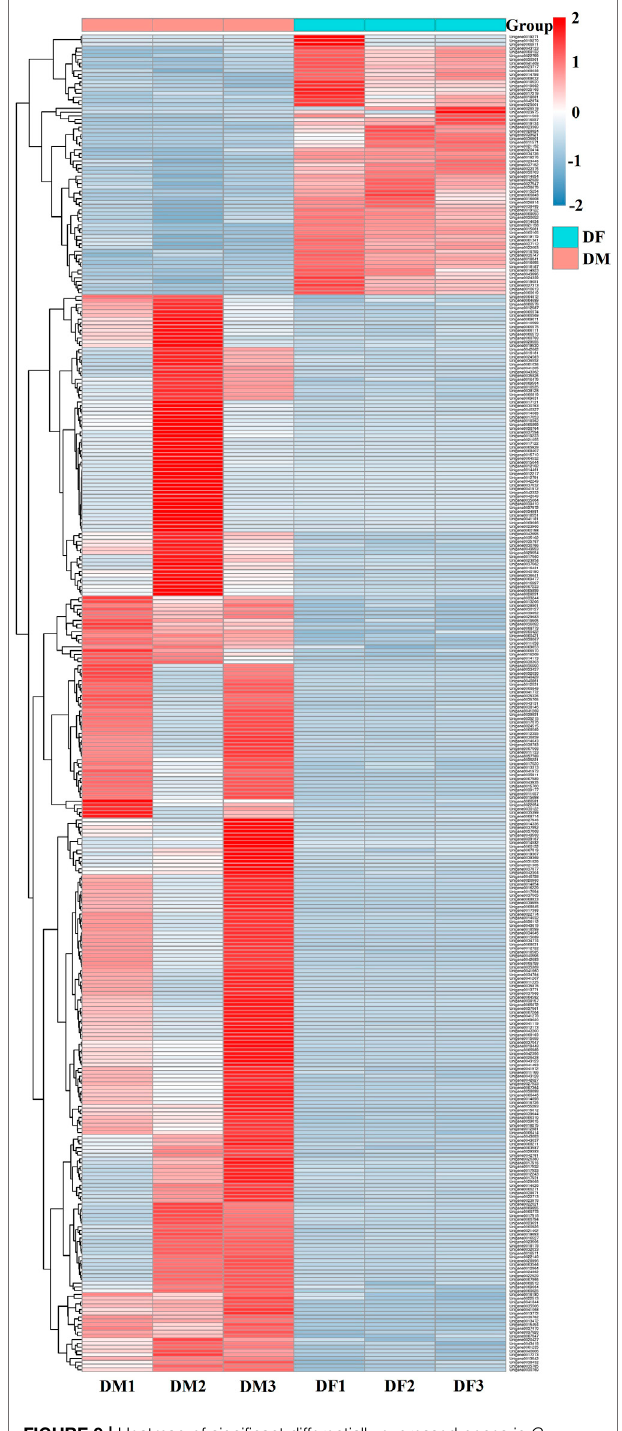
FIGURE 9 | Heatmap of signi fi cant differentially expressed genes in C. dieckmanni . Cluster analyses were based on log2RPKM. Each column represents a sample and each row represents a gene. Red boxes represent highly expressed genes. Blue boxes represent lowly expressed genes. DM1, DM2, and DM3 represent three replicate samples of males. DF1, DF2, and DF3 represent three replicate samples of females.